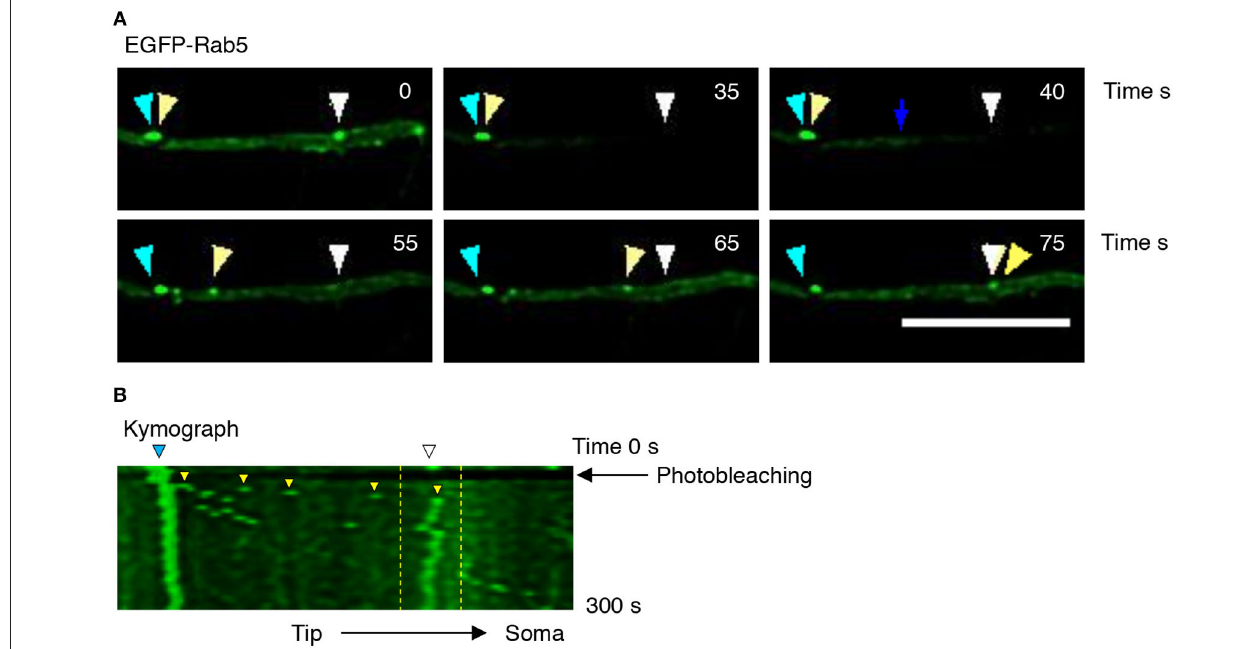
FIGURE 3 | Evaluation of EGFP-Rab5 movement by time-lapse microscopy after photobleaching in hippocampal neurons treated with BDNF. (A) Representative image of FRAP performed in primary dendrites of hippocampal neurons treated with BDNF. The recovery was evaluated during 300s. Images were taken every 7.3s. Representative individual frame of time-lapse performed in a neuron expressing EGFP-Rab5. The image shows both cytosolic-associated EGFP-Rab5 and vesicular-associated EGFP-Rab5 fluorescence (green) in dendrites prior to FRAP (0s), during FRAP (35s), and after photobleaching (until 75s). The blue arrow shows nonvesicular (or soluble) EGFP-Rab5 fluorescence recovery. The white arrowhead indicates a static endosome that is photobleached (35s), which is recovered after 40s by recruiting a mobile endosome, which is indicated with the yellow arrowhead. The cyan arrowhead shows a static endosome that generates the endosome labeled with a yellow arrowhead. Scale bar, 10 µ m. (B) Kymograph of the endosome movement event shown in (A) . In between the yellow lines is located the endosome recovered ( indicated by the white arrowhead in A) by a retrograde-transported endosome, which is indicated by the yellow arrowhead in (A) . The black arrow indicates the moment in which the photobleaching was performed